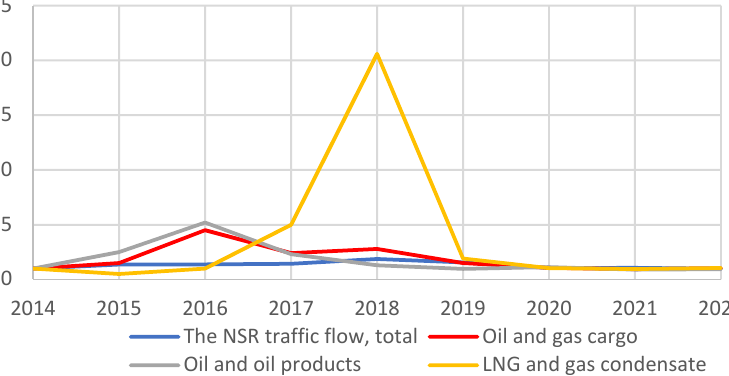
Figure 8. Chain indices of the NSR traffic flow in 2014–2022 by type of cargo units. Source: compiled by the author according to the data of [6,38,44,57,58].